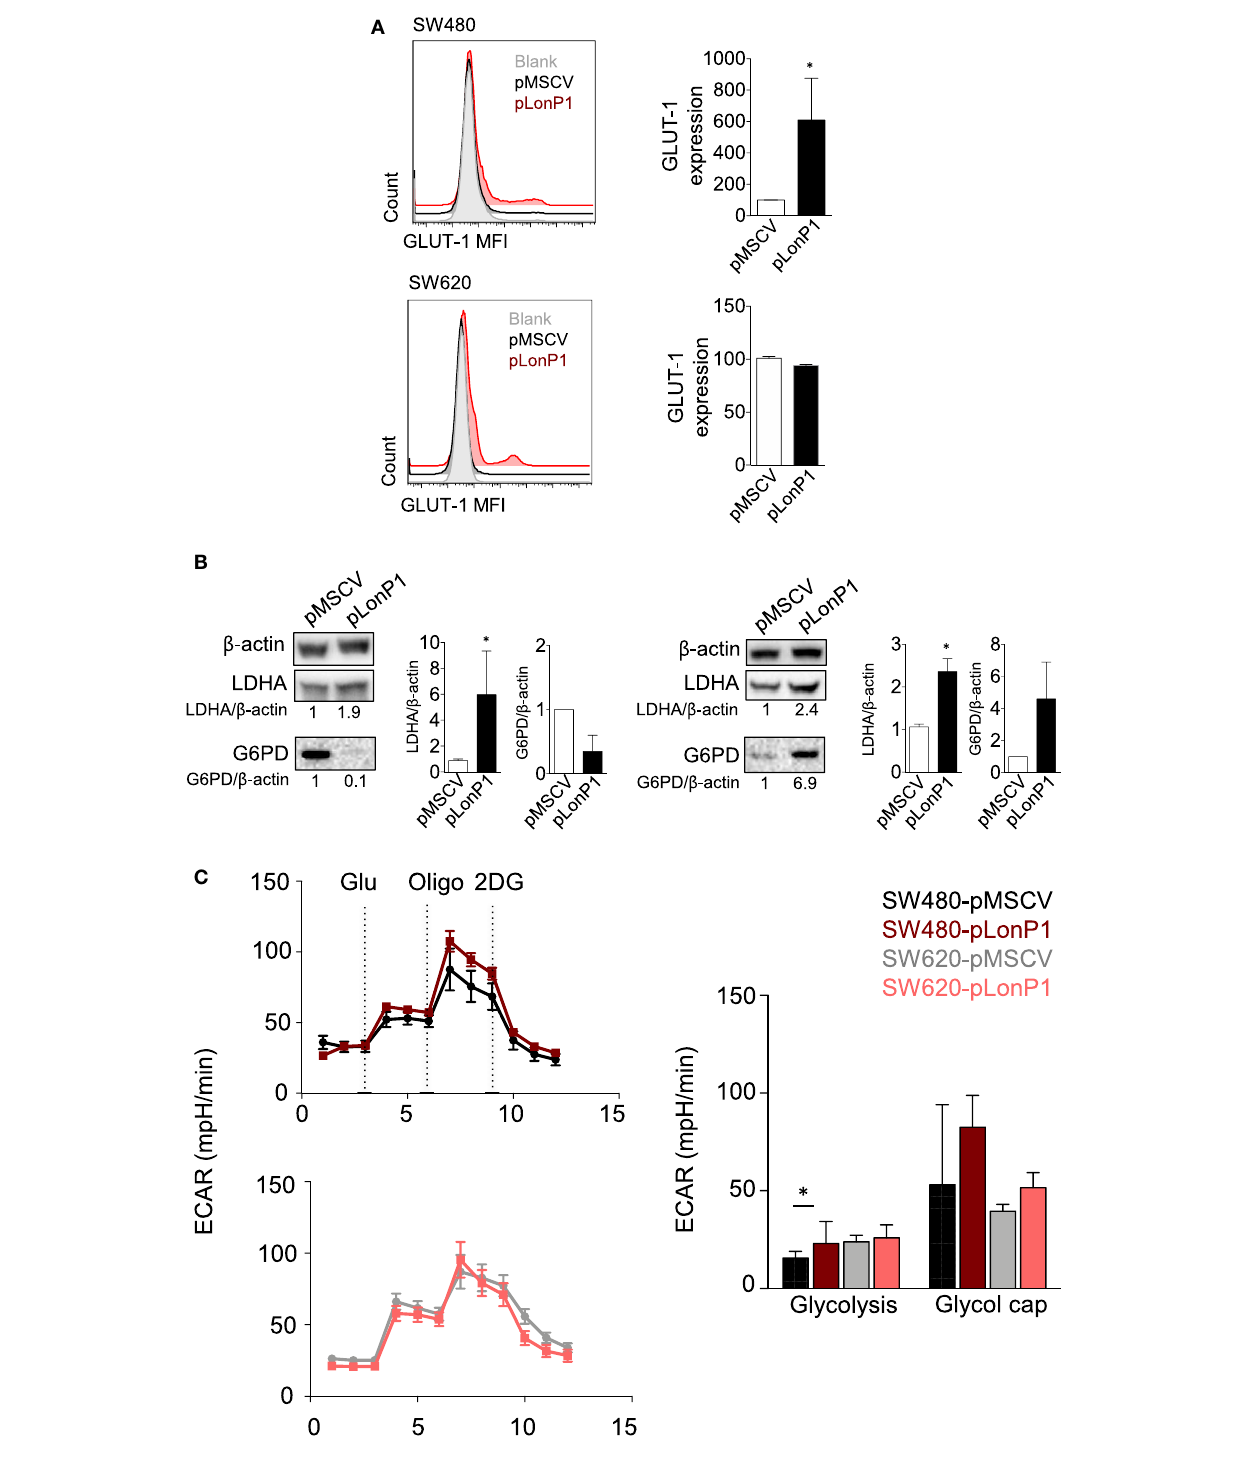
FigUre 6 | LonP1 modulates glycolytic activity in colon cancer cells. (a) Representative histograms showing glucose transporter (GLUT)-1 expression in SW480-pMSCV, SW480-pLonP1, SW620-pMSCV, and SW620-pLonP1 cells. Quantitative analysis is reported on the right and shows the median fluorescence intensity of plasma membrane GLUT-1 levels, as revealed by flow cytometry. (B) Representative Western blot analysis and relative protein levels of phosphorylated lactate dehydrogenase A and glucose 6-phosphate dehydrogenase in SW480 and SW620 cells overexpressing LonP1. β -actin was used as loading control. Densitometries are reported in histograms, and data are reported as mean ± SD ( n = 3). * P < 0.05. (c) Representative traces and quantitative analysis of extracellular acidification rate in indicated cells. Subsequent injections of glucose (Glu), oligomycin (Oligo), and 2-deoxy-glucose were performed as